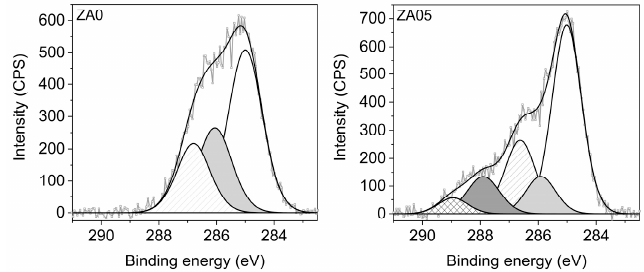
Figure 1. XPS C1s high resolution spectra of PPAAm after preparation (ZA0) and aging in a sealed aseptic packing at ambient conditions for 5 years (ZA5).